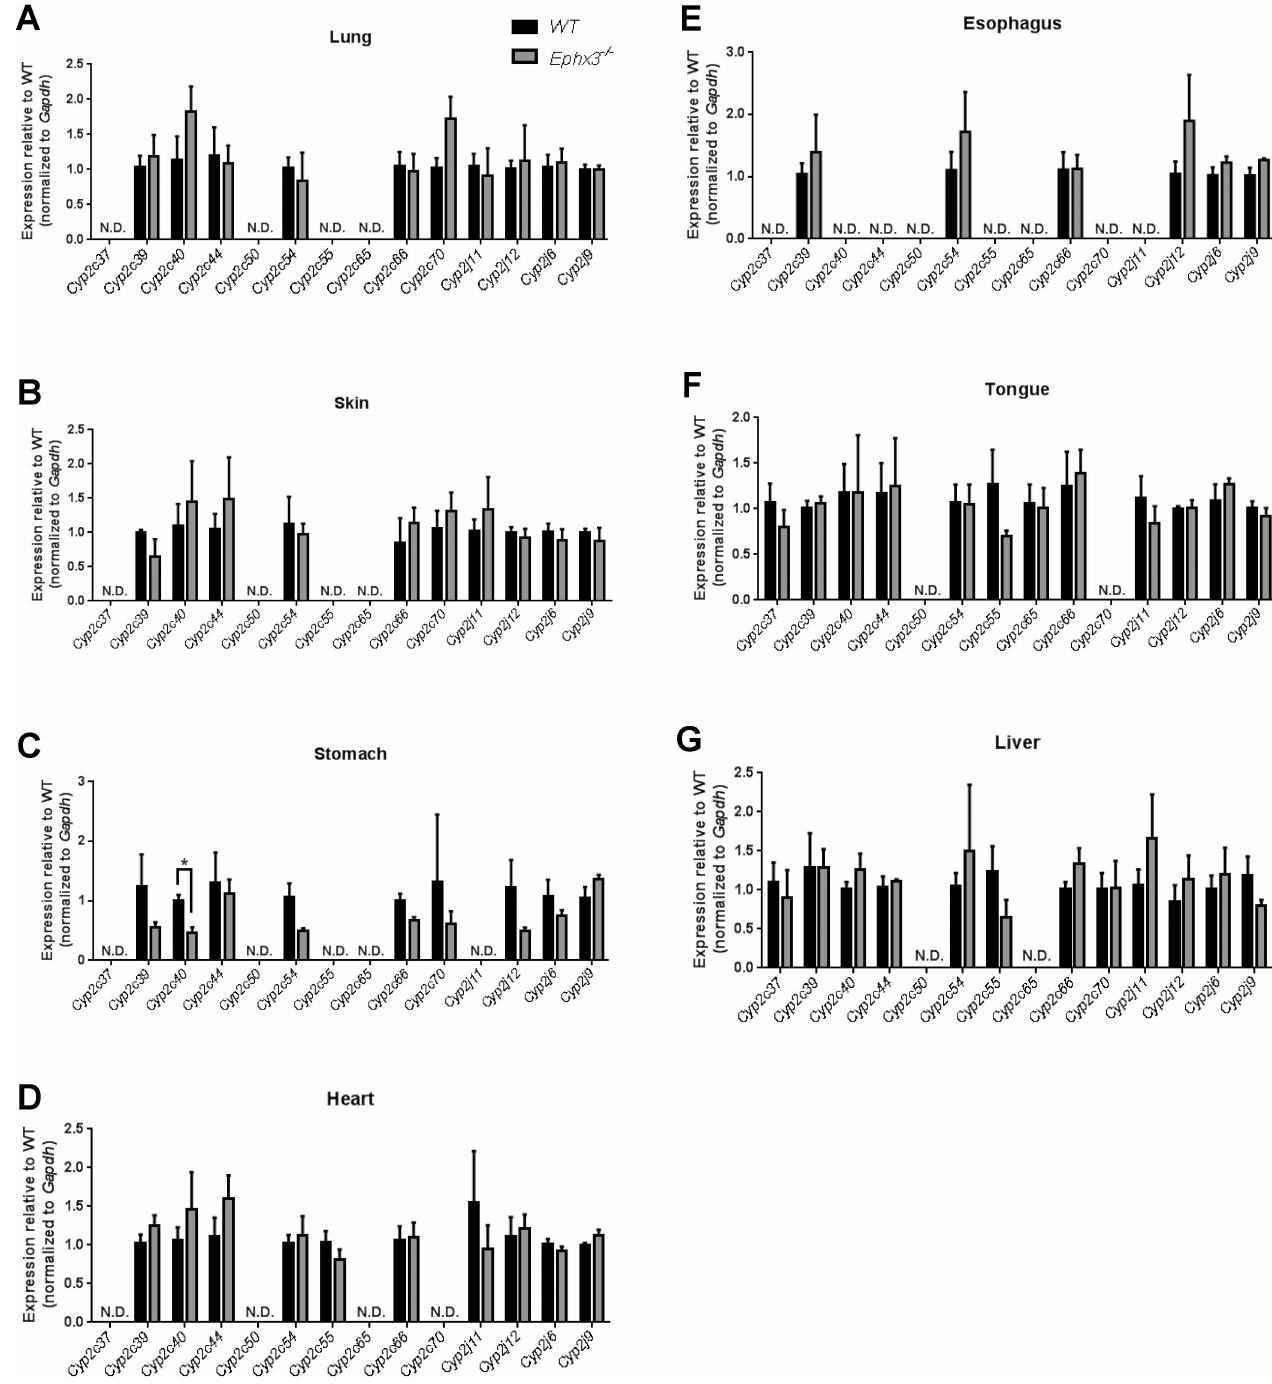
Fig 3. Disruption of Ephx3 does not alter mRNA levels of CYP epoxygenases. Quantitative RT-PCR of Cyp2c and Cyp2j isoforms in (A) lung, (B) skin, (C) stomach, (D) heart, (E) esophagus, (F) tongue, and (G) liver of Ephx3 -/- and WT mice. ( * p < 0.05;n = 3–5, p = NS).